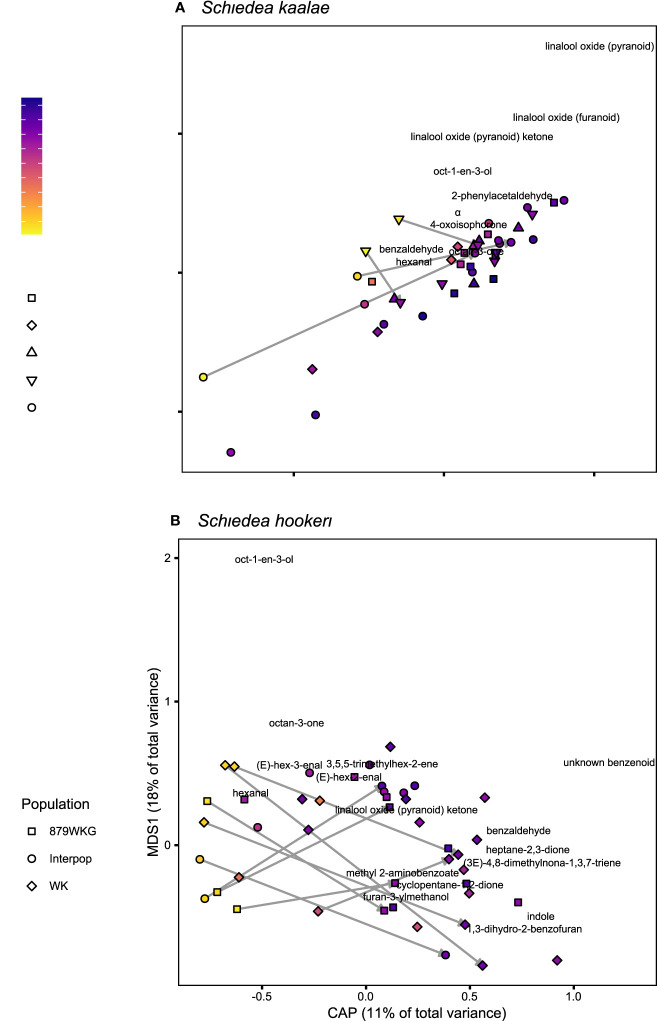
Floral scent composition determined by GC-MS of (A)
Schiedea kaalae and (B)
S. hookeri plants sampled at different times of day, visualized by canonical analyses of principal coordinates (CAP). The CAP axis shows scent variation explained by time of day (evening on the right), and the first multidimensional scaling (MDS) axis shows additional unconstrained scent variation. The shape of the points indicates the source population number (collection locations in Supplementary Table S1) or a plant from a cross between populations (“Interpop”). Color indicates the time of collection, with zero indicating sunset, positive values indicating time after sunset, and negative values indicating time before sunset. Arrows connect samples of the same inflorescence during the day and following night. The names of volatiles are positioned by their CAP and MDS scores and labelled if they are > 0.05 units from the origin.